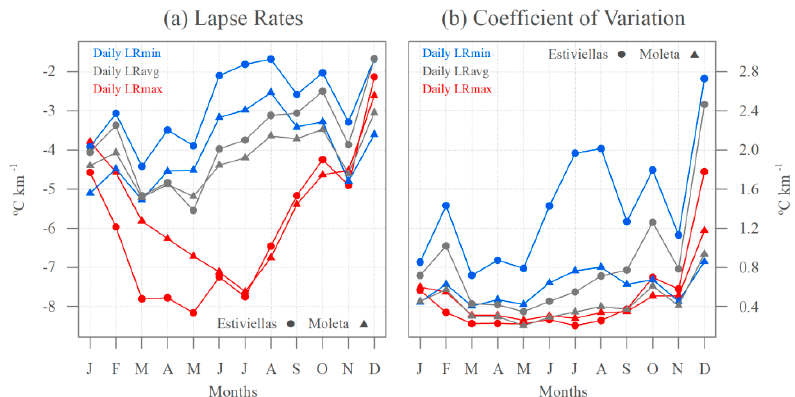
Figure 6. ( a ) Monthly maximum ( LRmax ), minimum ( LRmin ), and average ( LRavg ) air temperature lapse rates (measured in °C km − 1 ) from the Estiviellas and Moleta slopes; and ( b ) monthly LRmax , LRmin and LRavg coefficient of variation (in °C km − 1 ) from the Estiviellas and Moleta slopes.